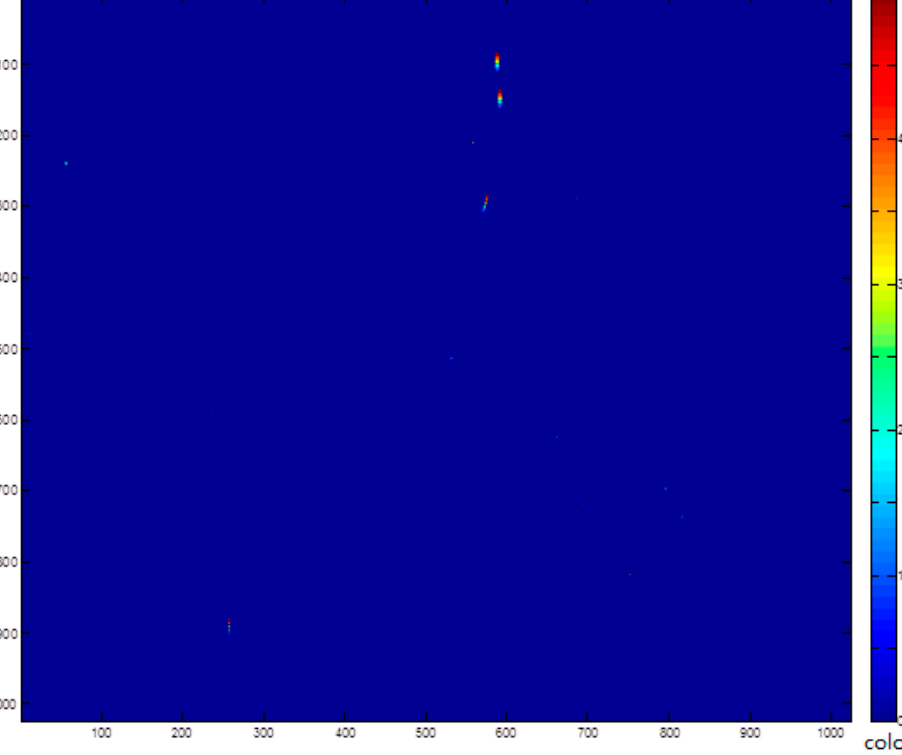
Figure 9. Target detection method based on time information. 4.3. Identification of Targets Observed in the Same Orbital Arc The effectiveness analysis of information obtained from a single star tracker shows that the magnitude brightness and velocity components of the debris are different with the observation position when the debris is observed with respect to different star track- ers, making it impossible to be used as the debris identification characteristic between the star trackers. The debris identifies the feature value. However, the geocentric obser- vation vector of the debris can be transformed by the observation vector of the star tracker and the rotation matrix between the geocentric coordinate system and the coor-